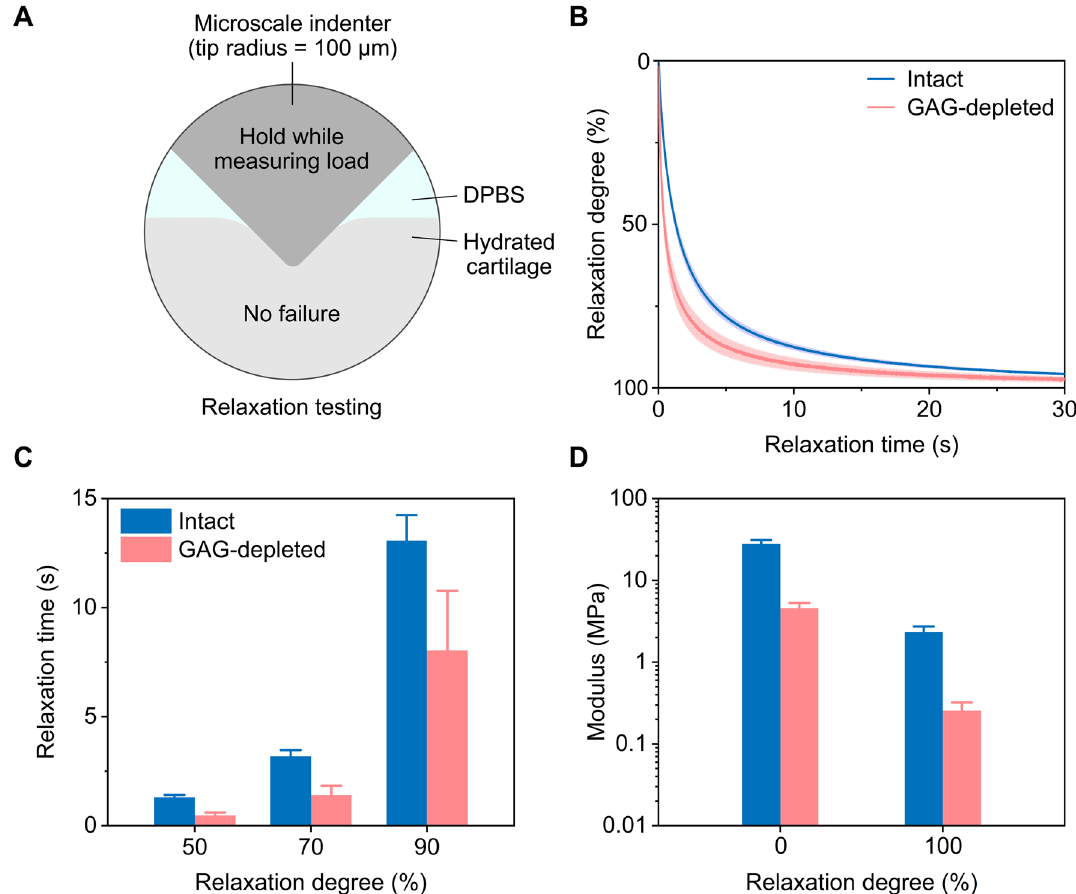
Figure 3. Relaxation responses of cartilage as a function of integrity. ( A ) Schematic illustrations of relaxation testing on intact and GAG-depleted cartilage via a microscale tip. ( B ) Relaxation curves as a function of time. ( C ) Relaxation times at different relaxation degrees. ( D ) Elastic moduli at two extreme relaxation degrees. The schematic diagram is not to scale. Averages and standard deviations were reported (n =